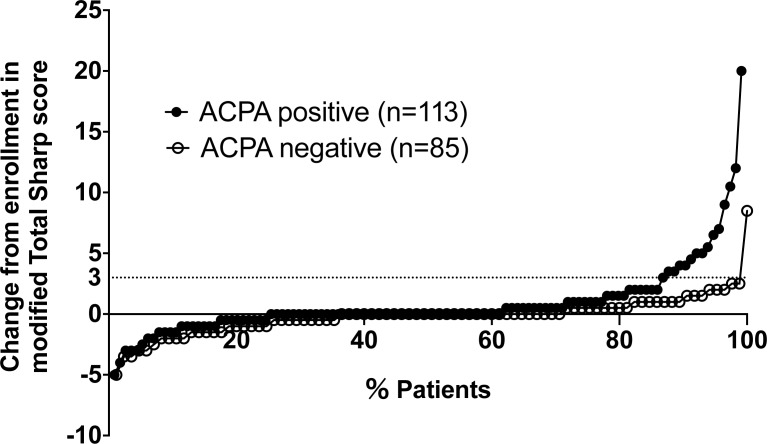
Cumulative probability plots of changes in mTSS for 1 year in the ACPA-positive patients versus the ACPA-negative patients.ACPA: anti-citrullinated peptide antibodies; mTSS: modified total Sharp score.